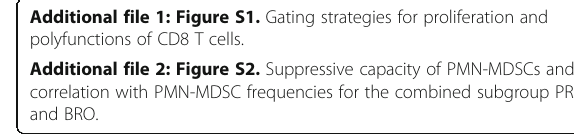
Additional file 1: Figure S1. Gating strategies for proliferation and polyfunctions of CD8 T cells. Additional file 2: Figure S2. Suppressive capacity of PMN-MDSCs and correlation with PMN-MDSC frequencies for the combined subgroup PR and